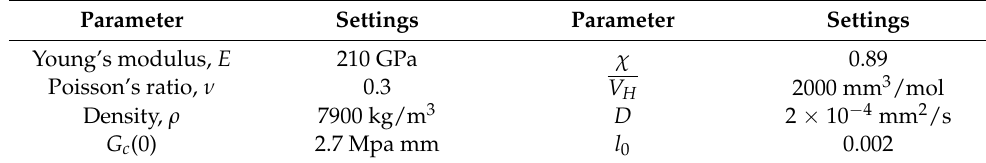
Figure 5. Model diagram of Case 1. Table 1. The parameter values in Case 1.